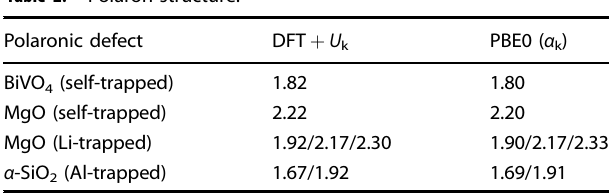
Table 2. Polaron